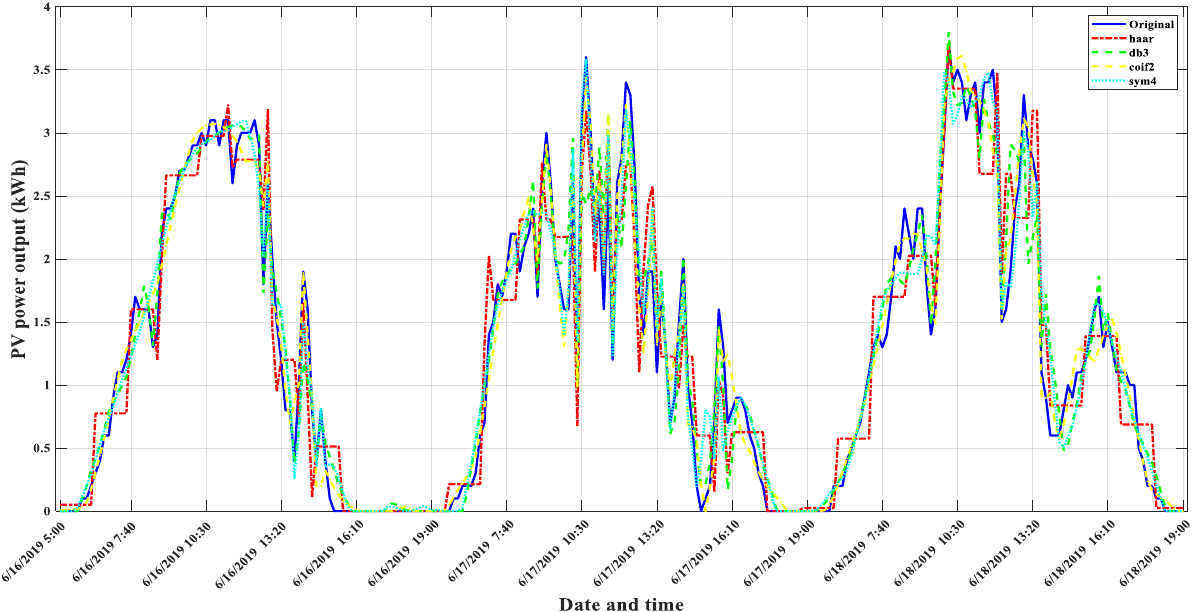
Figure 6. The original PV power output and different wavelet mother functions.